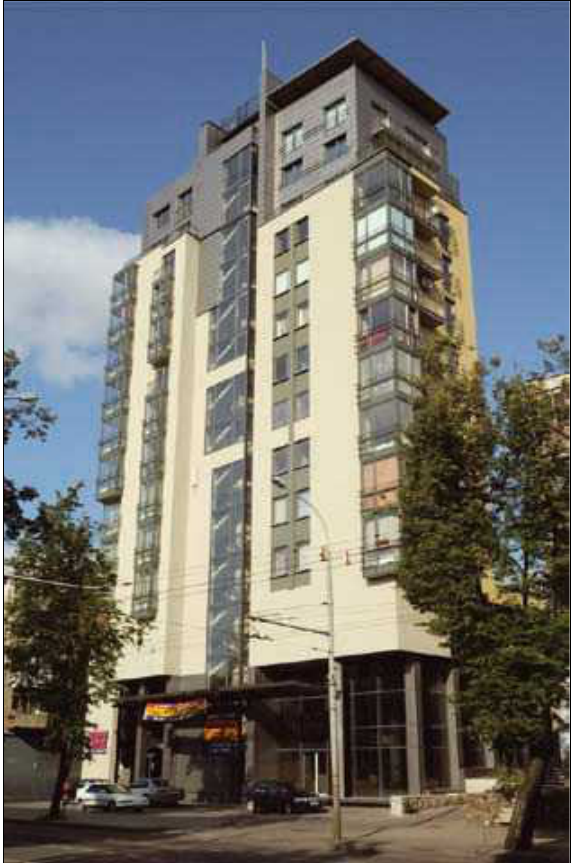
a­ntakalnio g. (archit. L. Šarkinas) Fig. 13. high-rise block of flats in a­ntakalnis st. a­rchit. L.